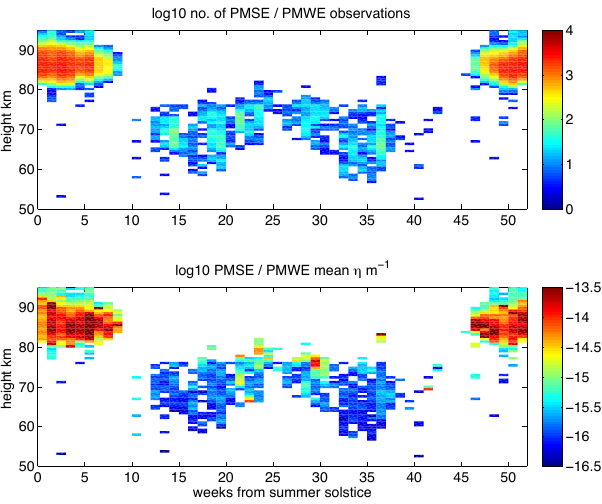
Figure 2. Upper panel: log 10 of the number of observations per week of PMWE and PMSE (observations made every 3min). Lower panel: average volume reflectivity (log 10 m − 1 ) in detected echoes (detection threshold 3 × 10 − 17 m − 1 ). Observations by MARA at Troll, Antarctica, during the 2-year period 10 January 2012–10 Jan- uary 2014 as a function of height and time of year (time resolution 1 week).